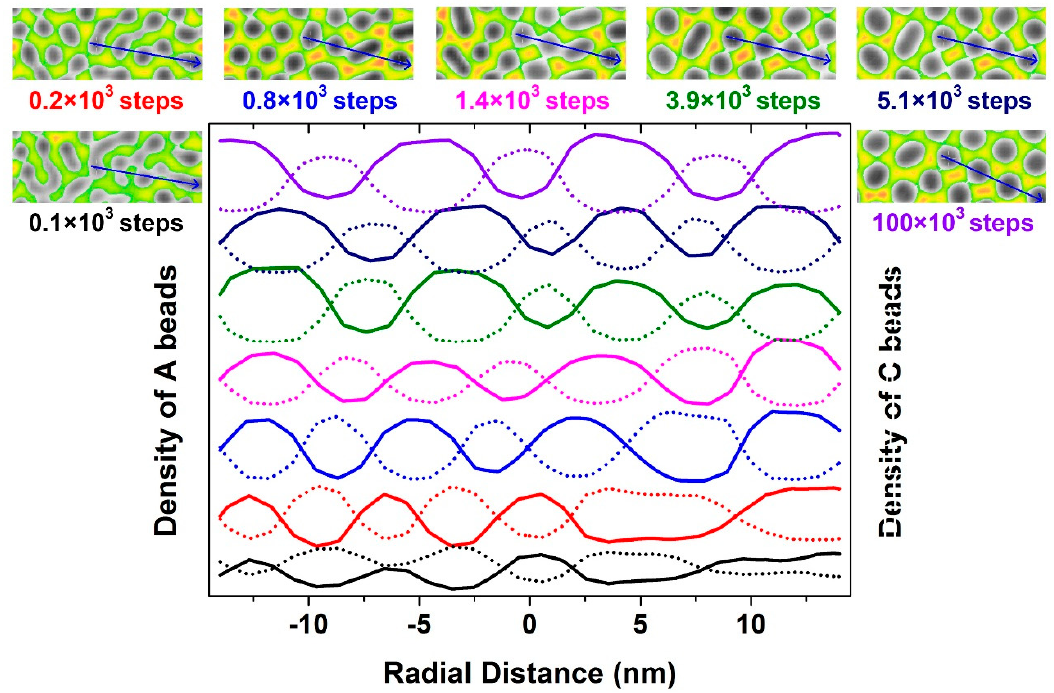
Figure 6. Density distributions of A beads (solid line) and C beads (dotted line) along the selected route—labeled in blue with arrows in the density slices at di ff erent times, i.e., 0.1 × 10 3 steps (in black), 0.2 × 10 3 steps (in red), 0.8 × 10 3 steps (in blue), 1.4 × 10 3 steps (in magenta), 3.9 × 10 3 steps (in olive), 5.1 × 10 3 steps (in navy), and 100 × 10 3 steps (in violet). The density slices are displayed at the top and from left to right, according to the time sequence.